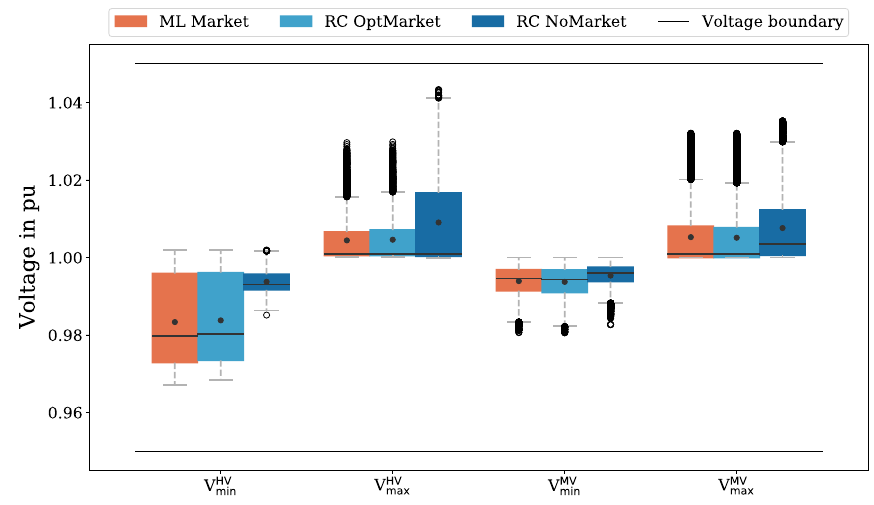
Fig. 8 Minimum and maximum node voltages of the individual grids, subdivided by the voltage